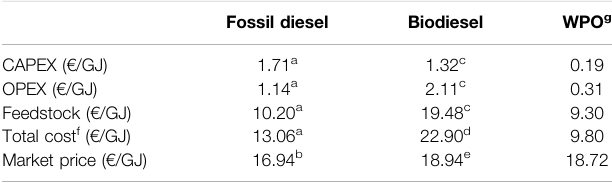
TABLE 3 | Production cost breakdown of diesel and alternatives. Densities and Lower Heating Values used are shown in Table 1 .